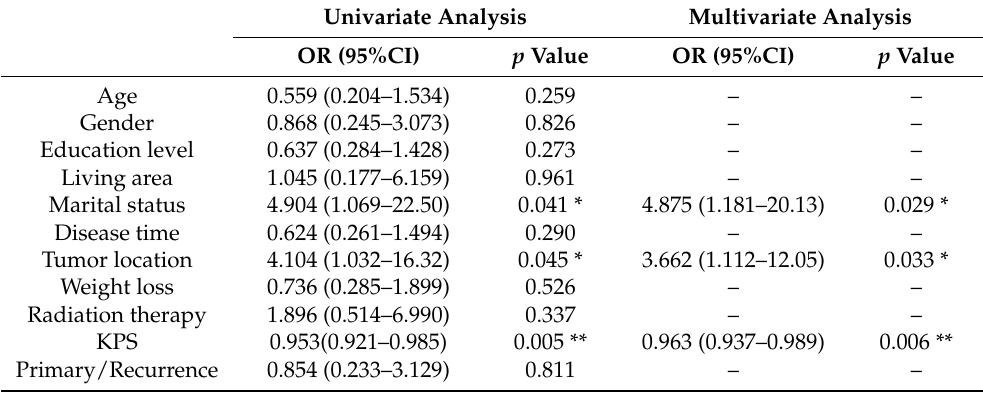
Table 5. Uni- and multi-variable logistic analysis of factors associated with